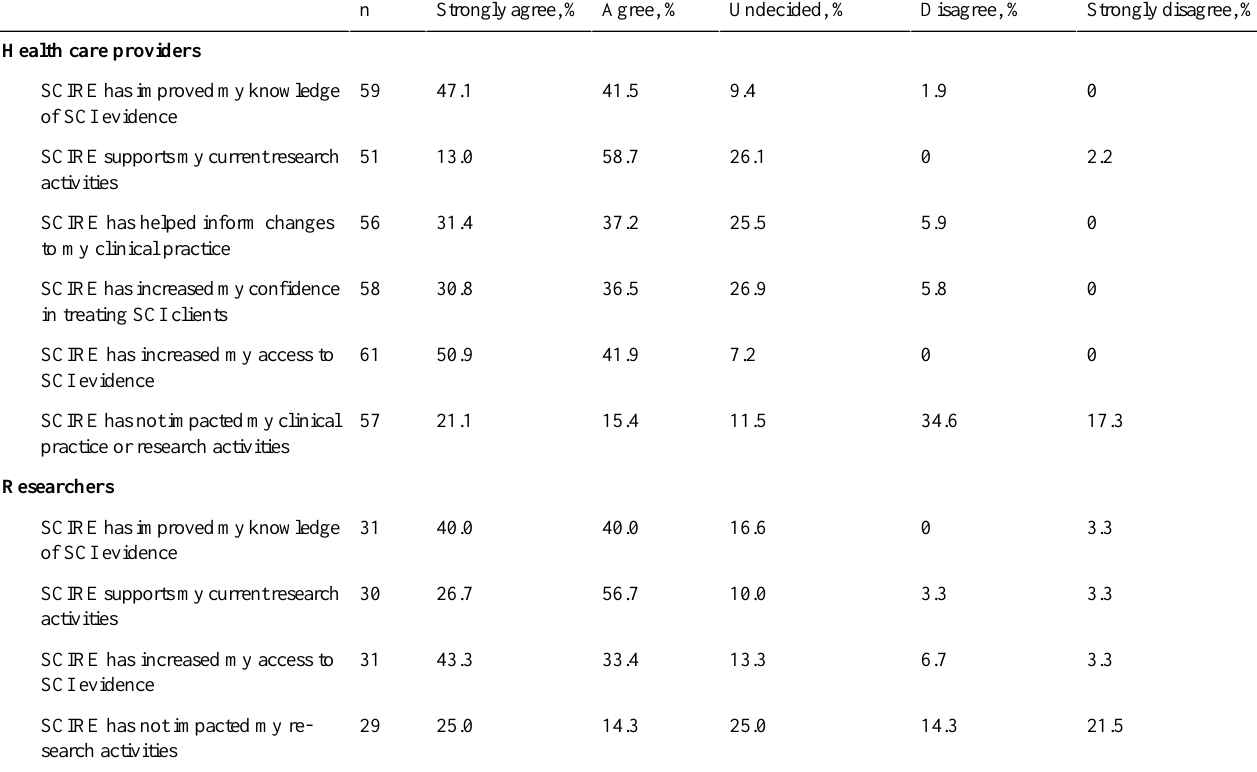
Table 2. Targeted user survey results showing impact of SCIRE on health care providers and researchers (62 health care providers and 31 researchers were surveyed, but some marked the item as not applicable and were not included in the percent calculation, eg, a clinician who had no research responsibilities for item